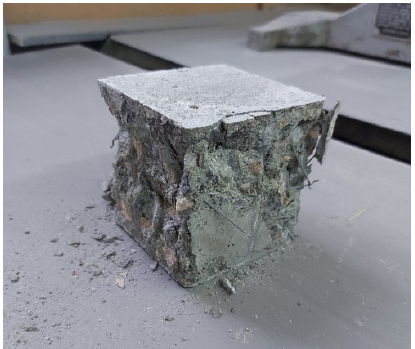
Figure 3. Steel-fiber-reinforced concrete specimen after compression strength test.